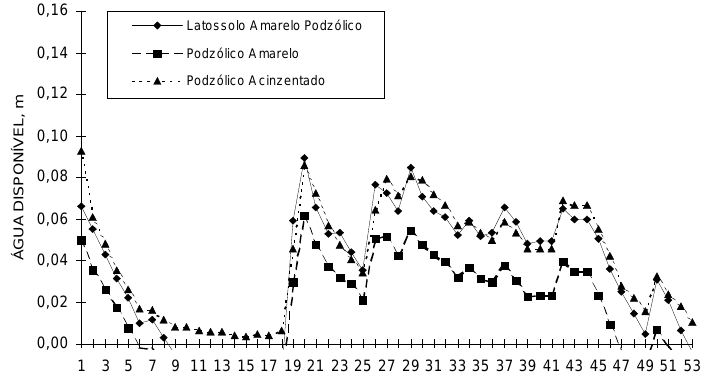
Figura 7. Água disponível até 1,10 m de profundidade, durante o período de um ano, a partir de 18 de dezembro de 1995, em uma toposseqüência de solos de tabuleiro cultivados com citros, no município de Sapeaçu (BA).